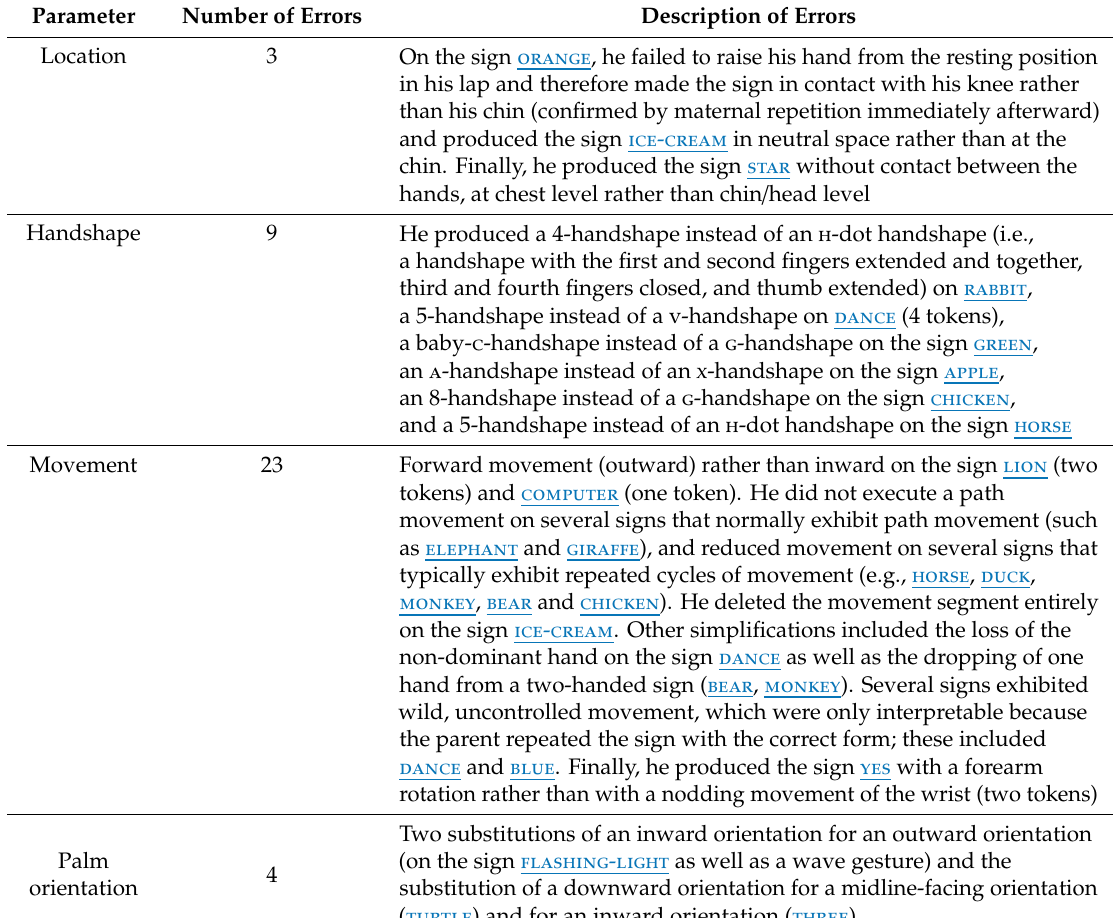
Table 1. Articulation errors previously reported at age